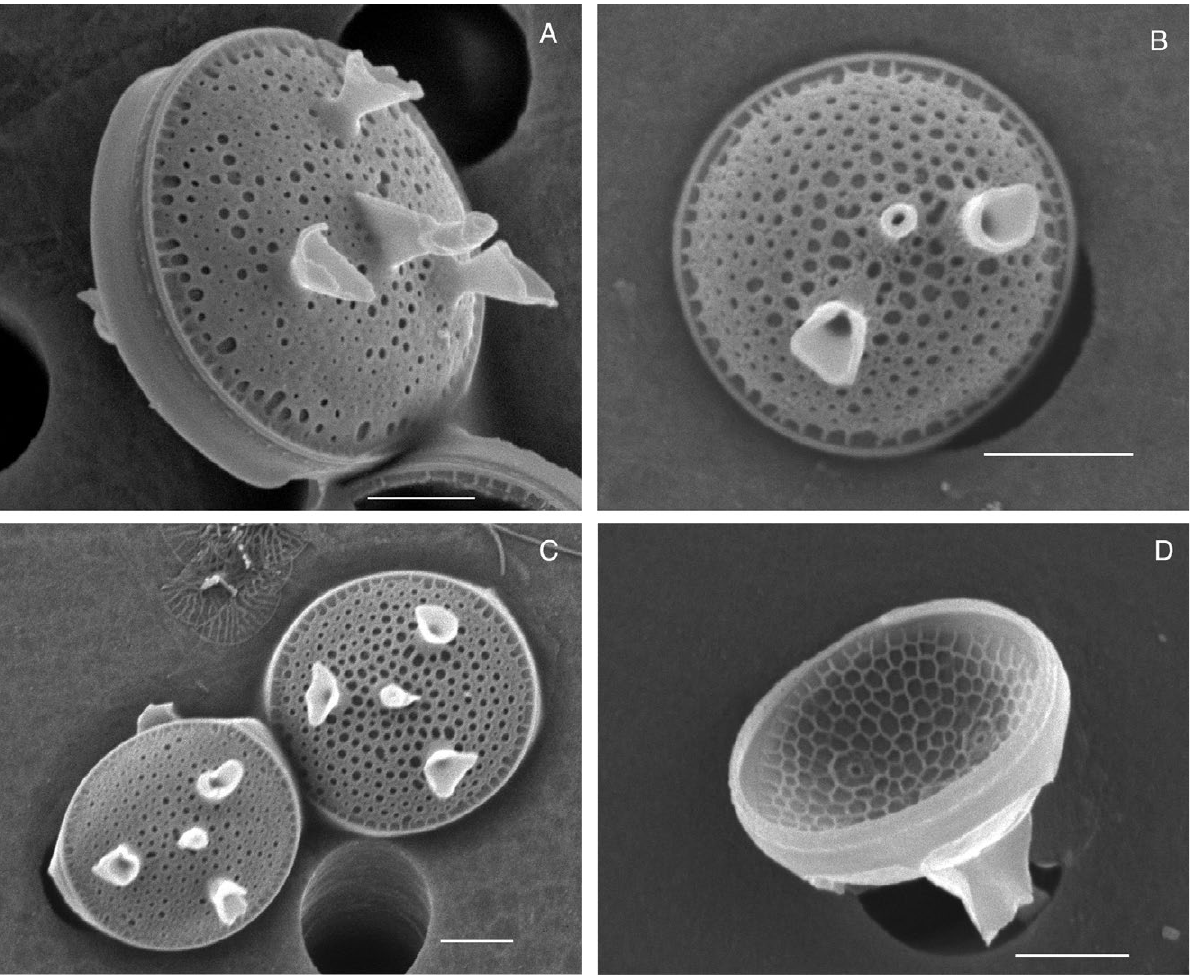
Fig. 1. – Minidiscus comicus showing the positioning of the central rimoportula and the arrangement of the surrounding fultoportulae. There are usually three fultoportulae per cell, but in the narrowest diameter valve, there are only two. A-C are external views of silicified cells. D is also an external view but of a partly silicified cell where the cell wall has become concave during preservation. It shows the hexagonal struc- ture of the side walls of the pseudoloculi, which are underlain by a basal membrane. A-C, 21 March 2009; D, 11 May 2009. Scale bar 1